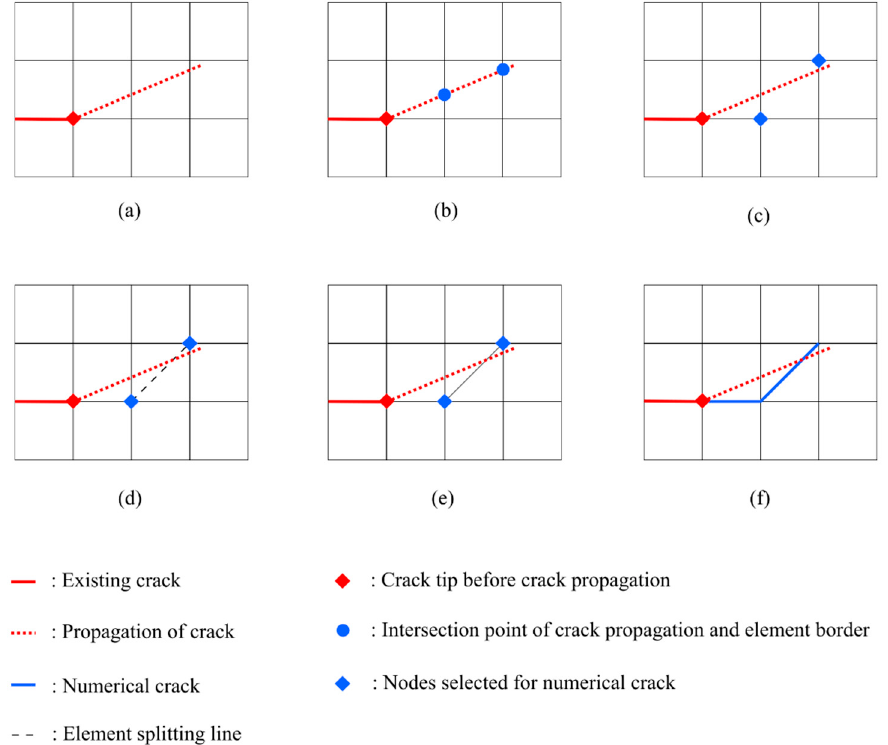
Figure 7. ( a ) Position of the crack and the crack propagation; ( b ) Intersection points of crack propa- gation and element edge are marked on the mesh; ( c ) Nodes with shortest distance to the intersec- tion points are selected for the numerical crack; ( d ) One of the elements is split for the numerical crack; ( e ) Mesh after element splitting; ( f ) Numerical crack is represented by separating relevant element edges.